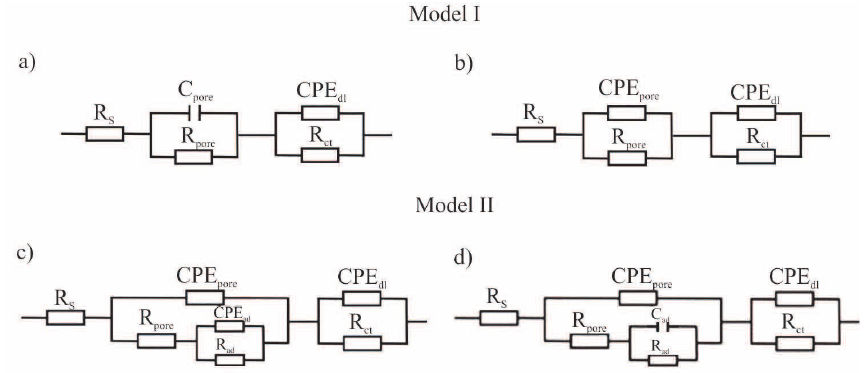
Figure 13. Alternative electrical circuits representing the corrosion systems: ( a ) sandblasted_initial state, ( b ) electropolished and sandblasted—500_300, ( c ) electropolished with ZnO layers, ( d ) sandblasted with ZnO layers besides 500_300.